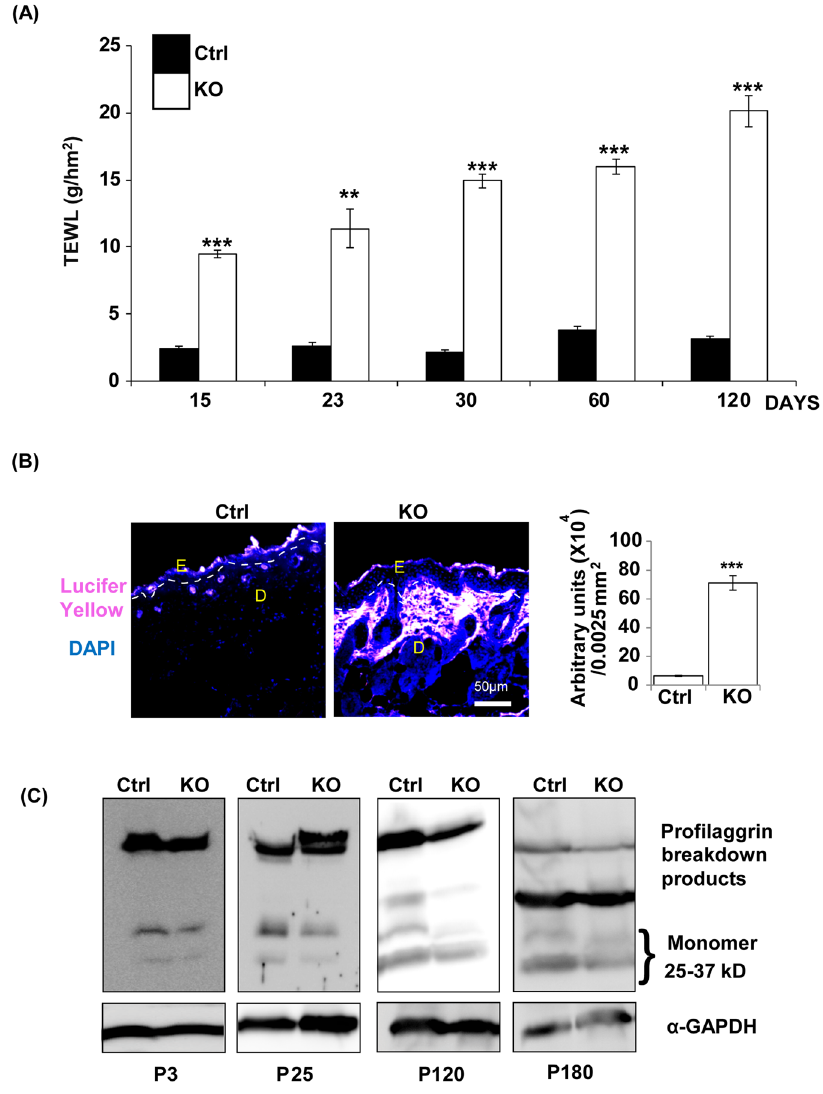
Figure 4. N-WASP knockout in keratinocytes causes a defect in epidermal barrier function. (A) Tewameter analysis showed increased transepidermal water loss (TEWL) in N-WASP K14KO mice skin compared to control mice on P15, P23, P30, P60 and P120 day (n = 6). (B) Enhanced penetration of Lucifer Yellow into the skin of N- WASP K14KO mice compared to skin of control mice. (C) Western blot analysis showed comparably reduced filaggrin expression in N-WASP K14KO mice skin compared to control mice on P3, P25, P120 and P180 (n = 3). Results are mean ± SEM *** p < 0.001, ** p <